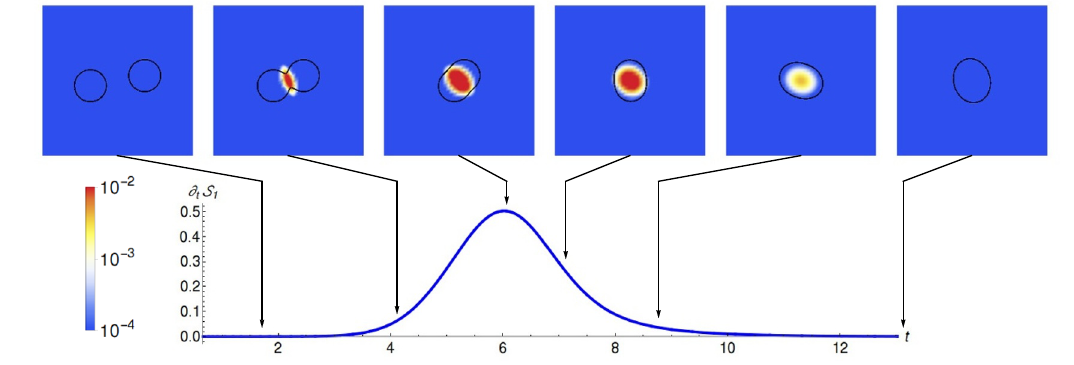
Figure 12 . Entropy production during a charged collision with fusion into a stable black bar. At LO in the e(cid:11)ective theory, entropy is generated through charge di(cid:11)usion only. The initial parameters are q 1 = (cid:0) q 2 = (cid:0) 0 : 6, a 1 = a 2 = 0 : 4, u 1 = (cid:0) u 2 = 1, b = 2, with total mass M =